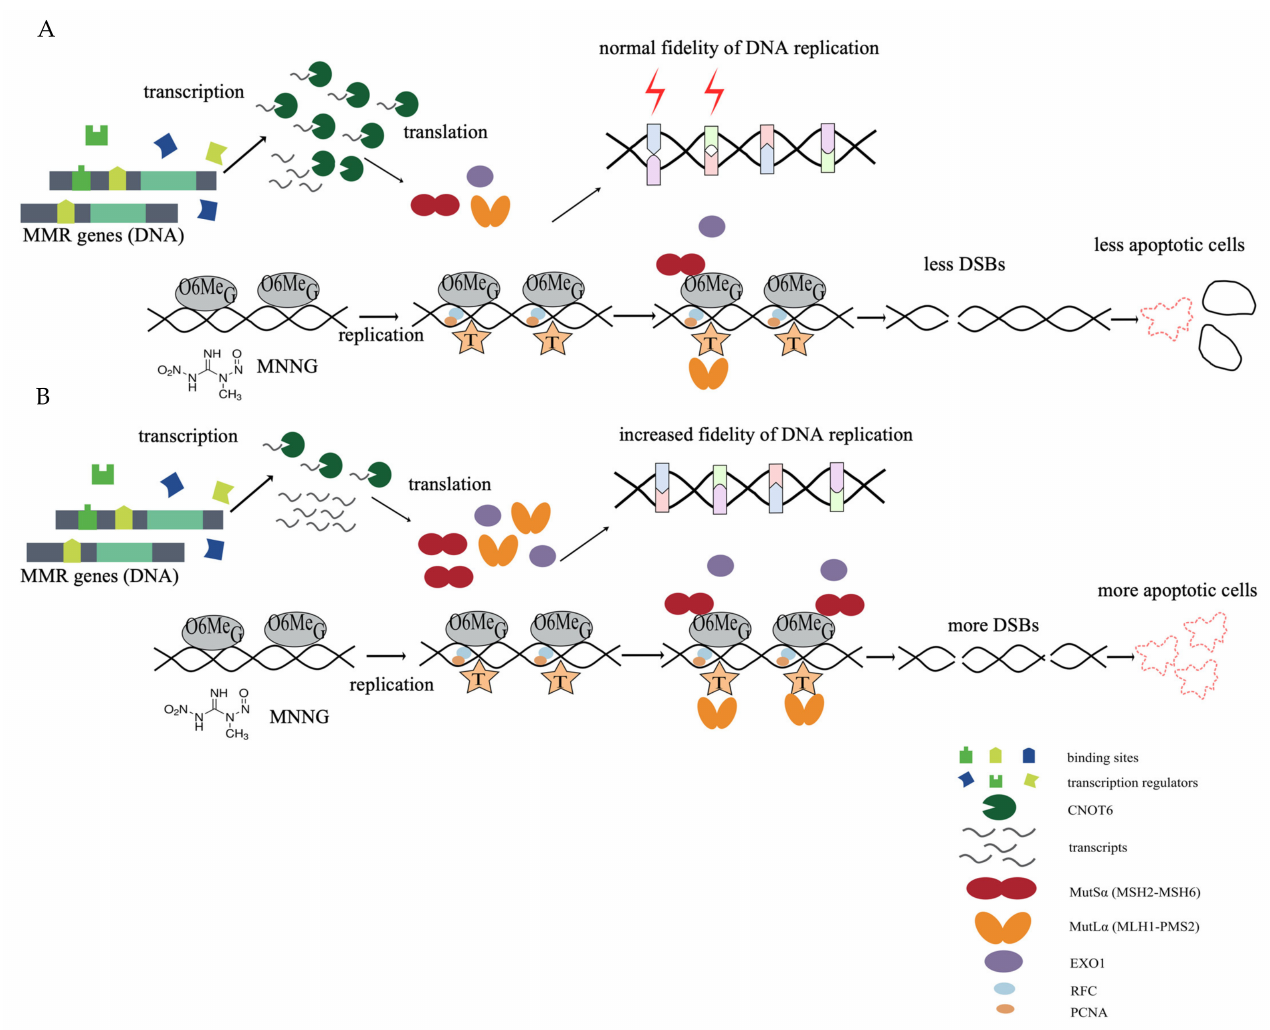
Figure 4. Proposed model for the regulation of MMR by CNOT6. ( A ) The stability of MMR transcripts under normal condition. ( B ) Depletion of CNOT6 leads to enhanced MMR, follow by increased DSBs and apoptosis. To explain the increased DSBs and apoptosis in CNOT6-depleted cells after MNNG treatment, there are several hypotheses. (a) The depletion of CNOT6 leads to unbalanced increase of MMR proteins, due to the different extension of mRNA half-life. (b) Increased MMR proteins may lead to more proteins that bind to the mispairs, which could impede the repair progress. (c) MMR can suppress recombination, which is important in DSB repair. (d) Processing by multiple